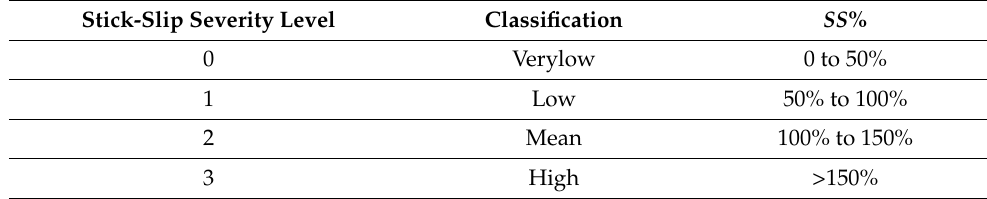
Table 1. Stick-slip severity